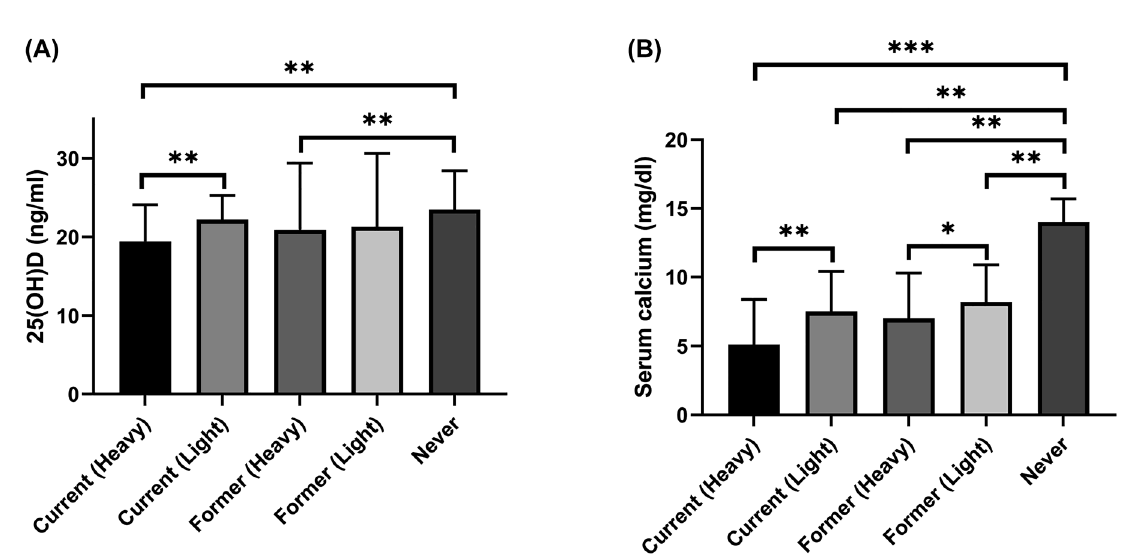
Figure 1: Mean concentrations of serum 25(OH)D (A) and calcium (B) in never-smokers, former smokers, and current smokers. The groups of former smokers andcurrent smokers werefurtherclassi fi ed intothe light smokers (<20cigarettes per day) andheavy smokers ( ≥ 20 cigarettes per day), respectively. The values were presented as means and standard errors. *p<0.05, **p<0.01,